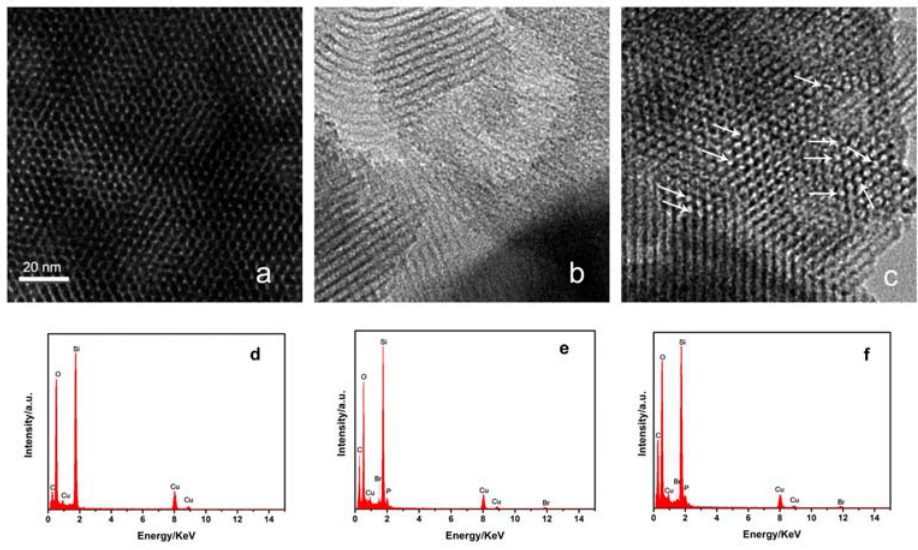
Figure 2. TEM images and the corresponding EDX spectra of SiO Br/SiO ( b , e ), and P Br@SiO ( c , f ). The scale bar in ( a ) applies to all three P 44416 2 44416 2 images. The arrows show the existence of ILs in